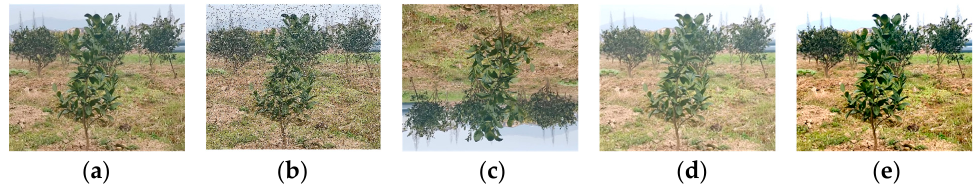
Figure 4. Data augmentation process: ( a ) Original image; ( b ) Add Gaussian noise; ( c ) Rotate; ( d ) Enhance brightness; ( e ) Enhance contract.